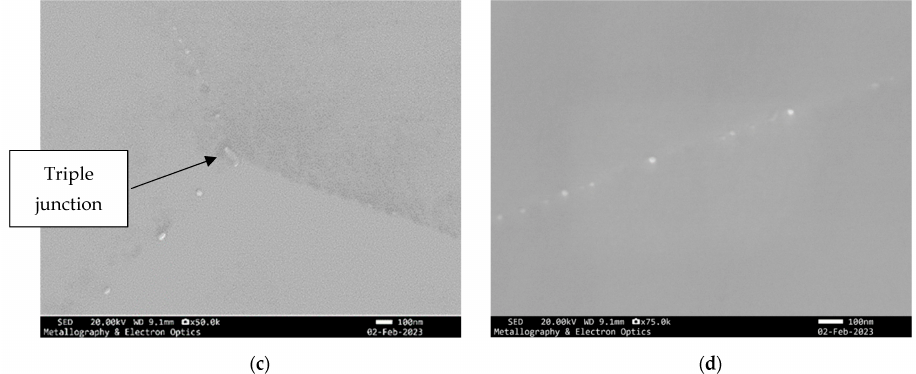
Figure 6. ( a ) EBSD misorientation map of the subsurface region of the SC sample. ( b ) Taylor factor map of the same area. ( c ) Grain boundary precipitation on HAGBs and absence of precipitates on LAGBs in AOI 1. Coarse precipitates formed on the triple grain boundary. ( d ) Grain boundary precipitation on another LAGB (AOI 2).